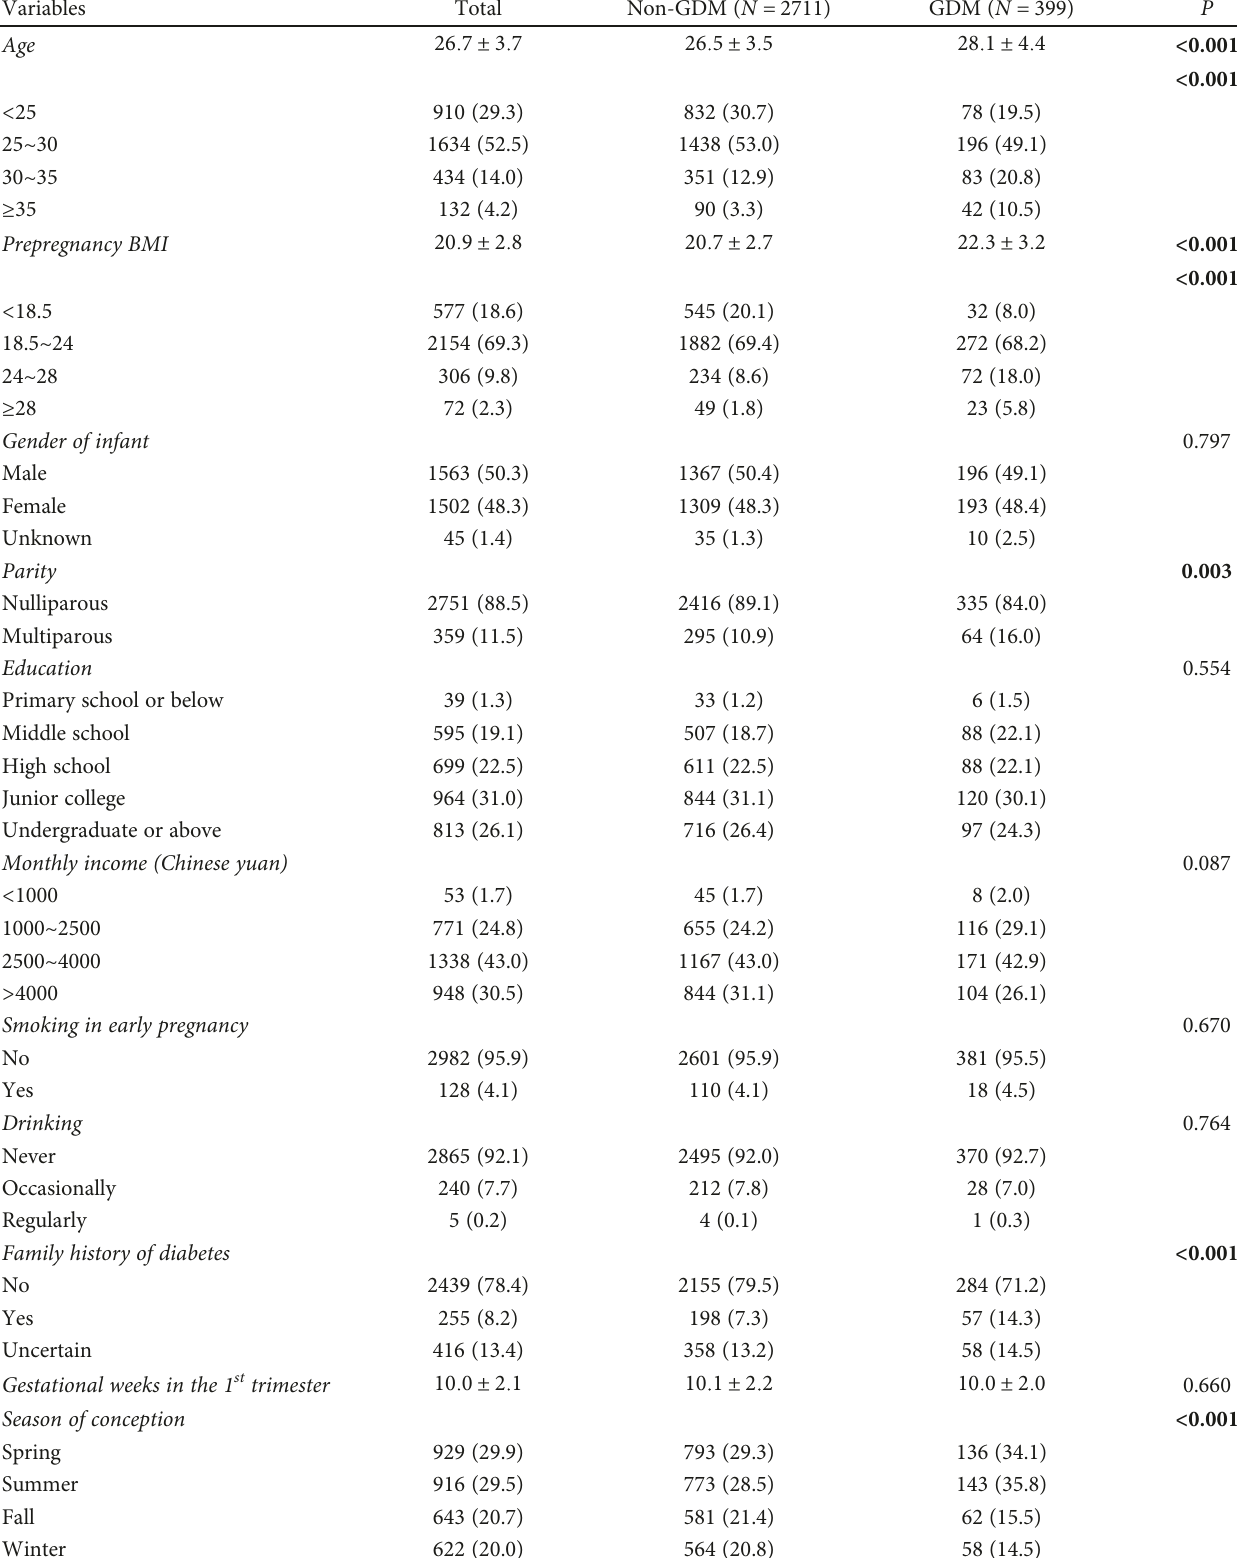
Table 1: Characteristics of women included for investigating the association of vitamin D concentrations and the risk of